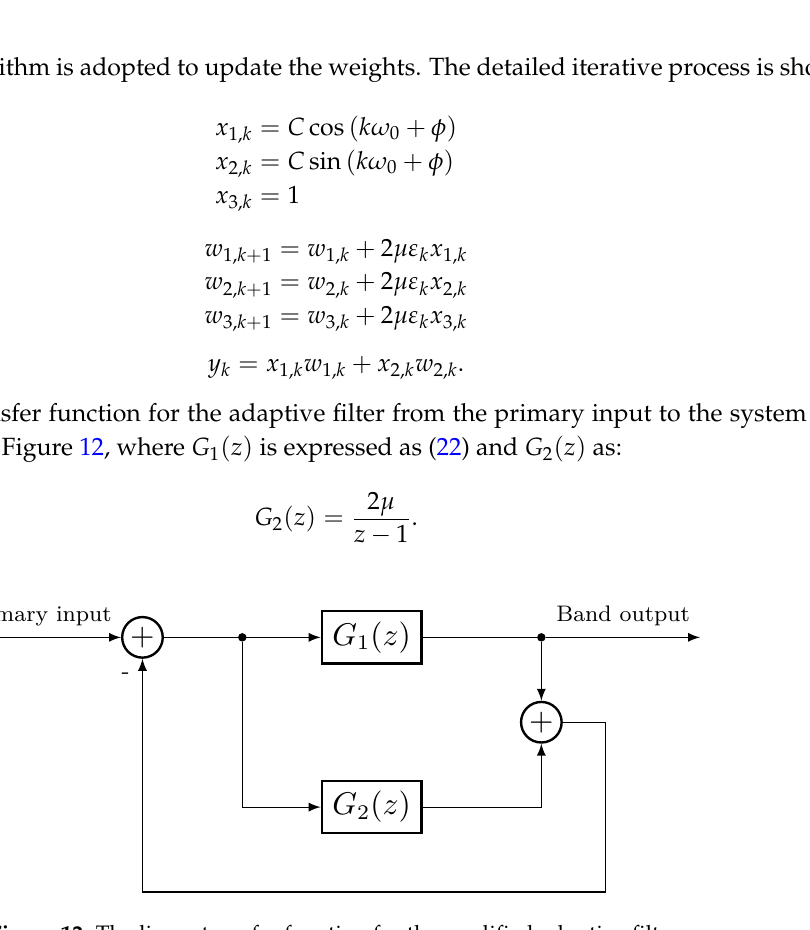
Figure 12. The linear transfer function for the modified adaptive